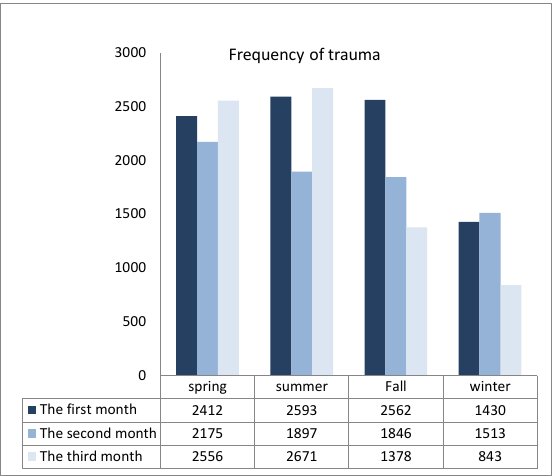
Figure 2. Frequency graph of organs